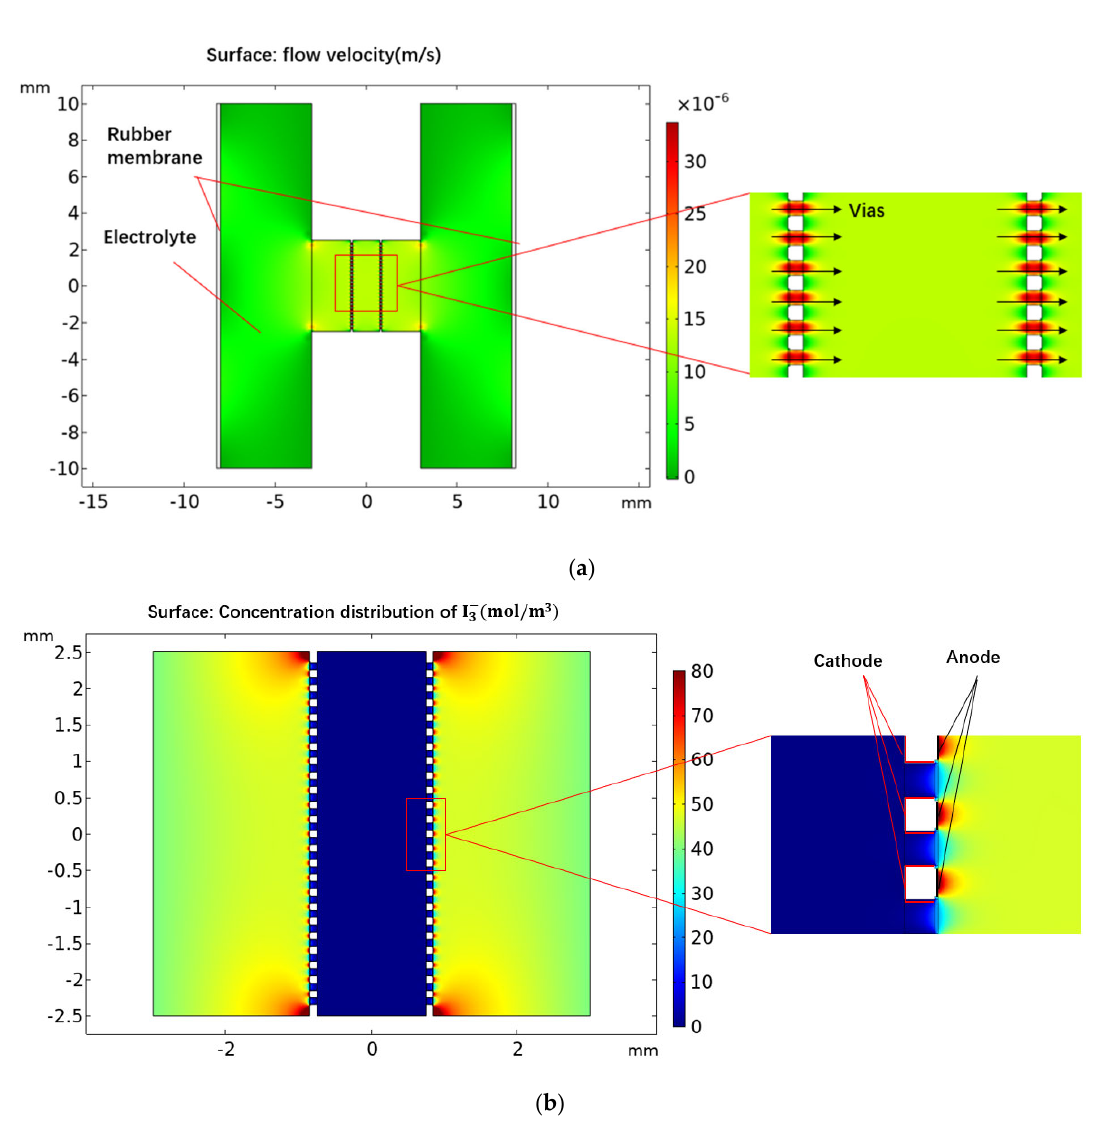
Figure 2. Simulation model of electrochemical vibration sensor: ( a ) simulation model of the vibration module; ( b ) simulation model of electromechanical module.